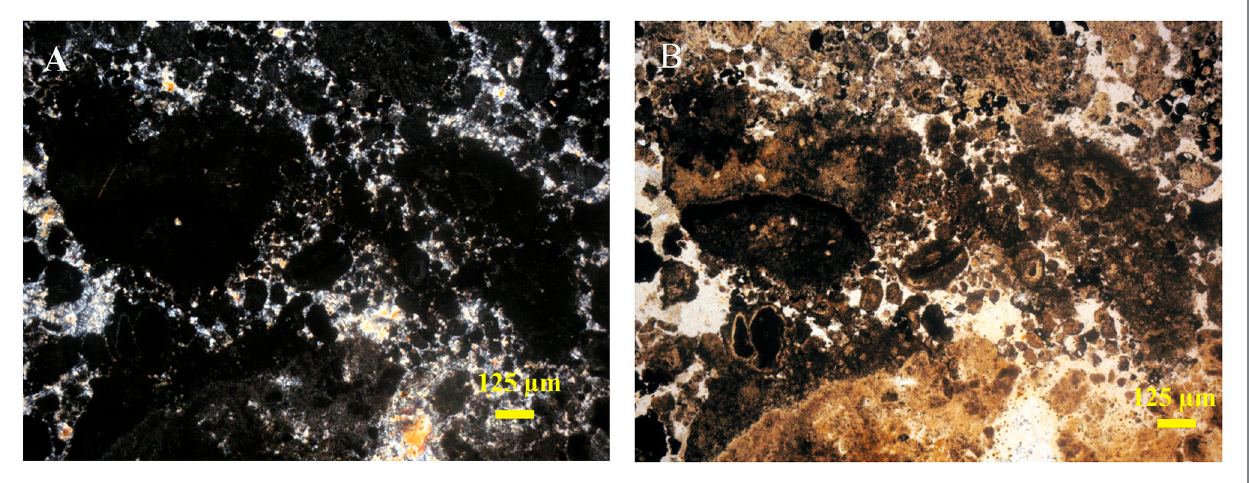
FIGURE 8 – Photomicrographs of sample 2574. A) Natural light photomicrograph showing domains of amorphous silica and fibro- radiated chalcedony. B) Photomicrograph identical to the previous one, in polarized